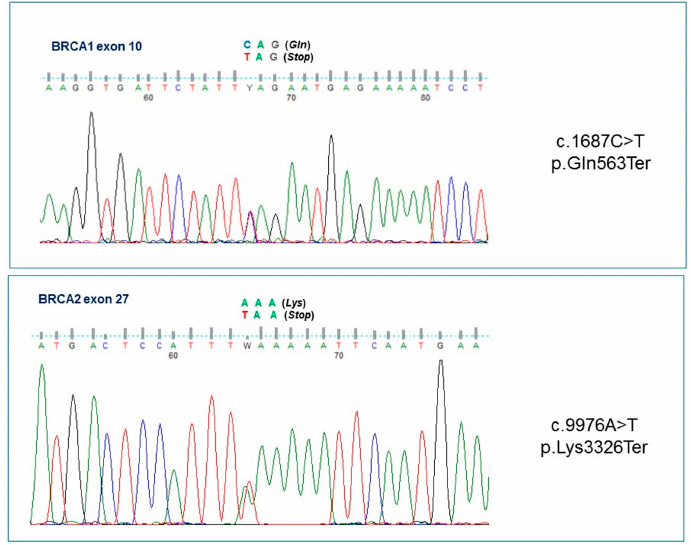
Figure 1. Direct sequence analysis of the BRCA1 c.1687C>T and BRCA2 c.9976A>T variants.